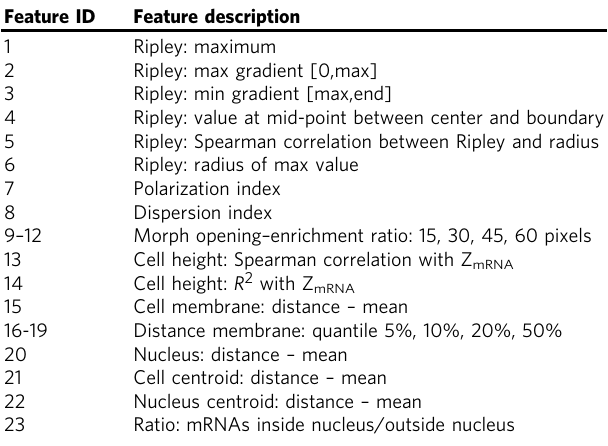
Table 1 List of localization features used in Figs. 3 and 4 Feature